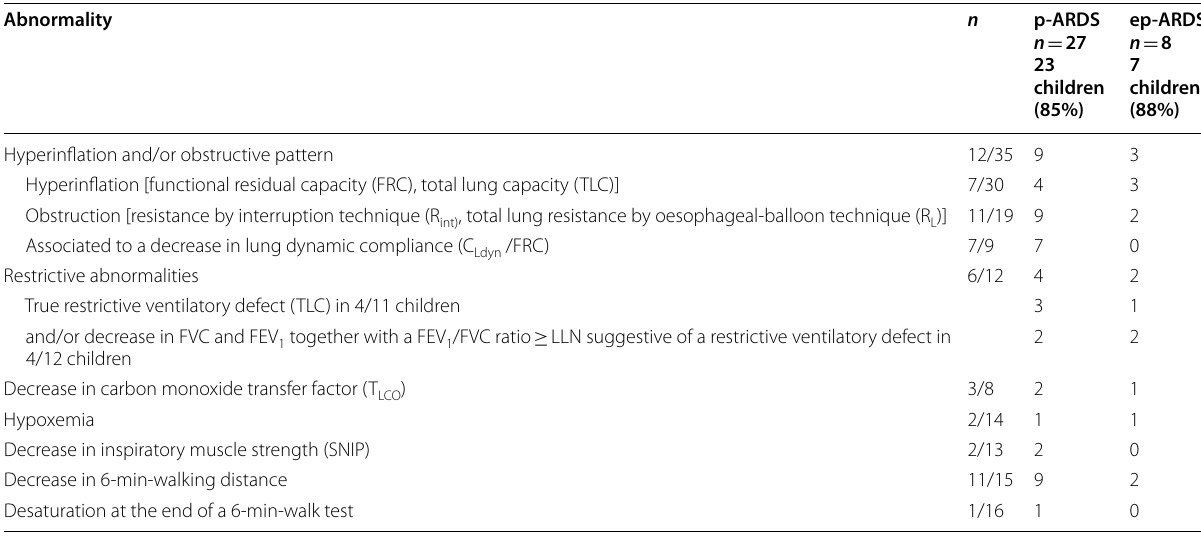
Table 5 Summary of abnormalities in PFT (all ages) in 35 children by type of